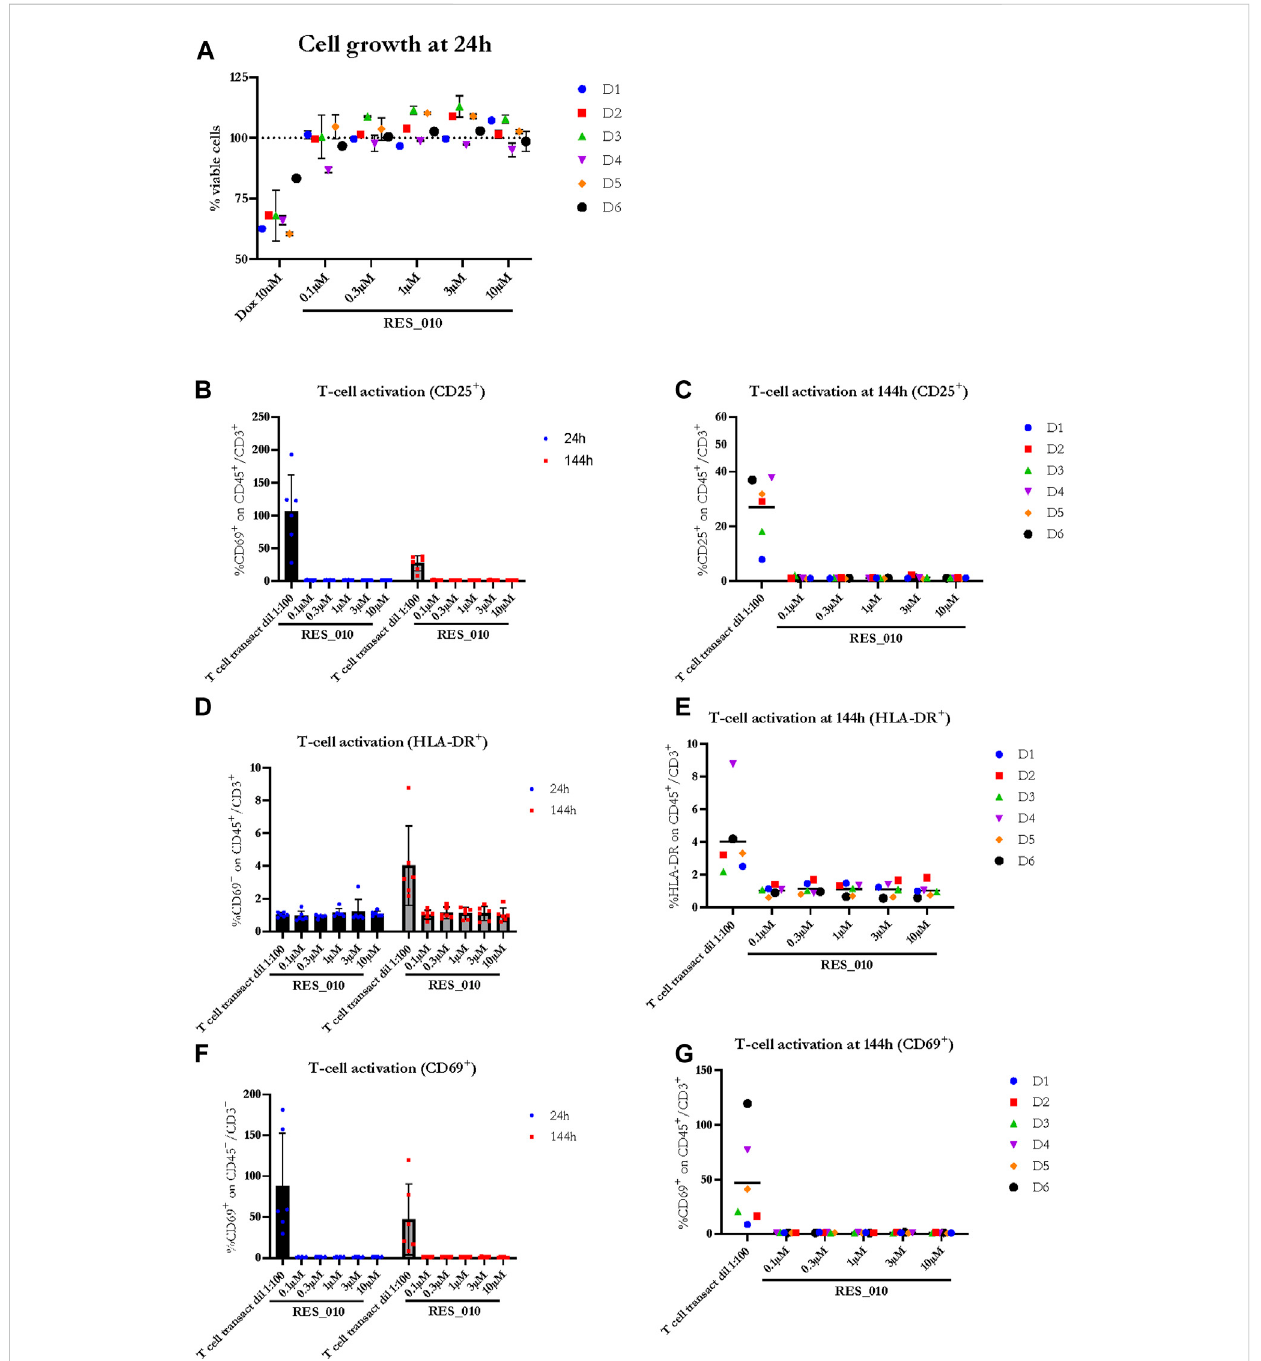
FIGURE 2 The effect of RES-010 on cell viability and T-cell activation. Cell viability for each one of the donors 24 h after RES_010 treatment is reported in (A) . (B,D,F) representthecumulativedataon%ofCD69,HLA-DRand CD25 positivecells respectively onthetotalCD45/CD3 doublepositive portion atboth 24 and 144 h after RES_010 treatment. (C,E,G) represent data at 144 h for single